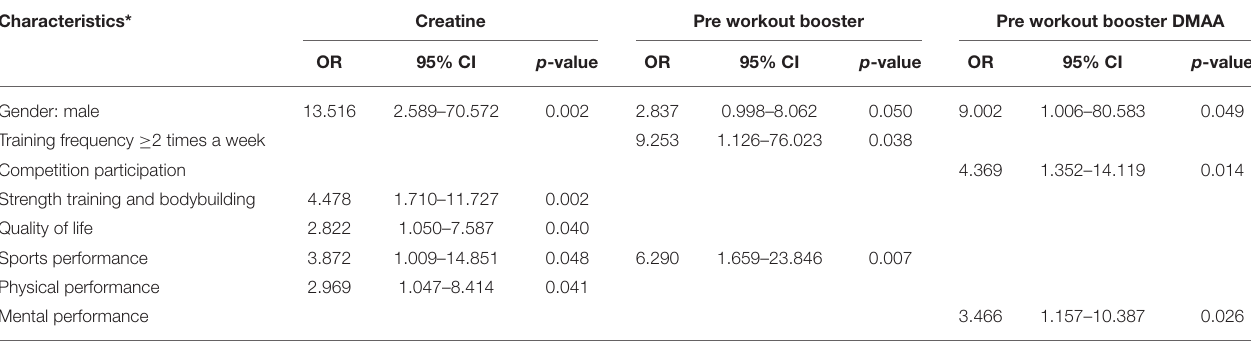
TABLE 6 | ORs with 95% confidence intervals for each significant predictor variable.